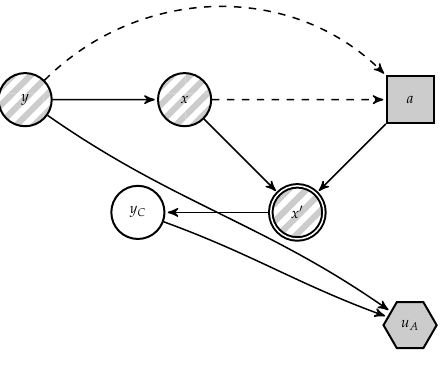
Figure 4. Adversary problem